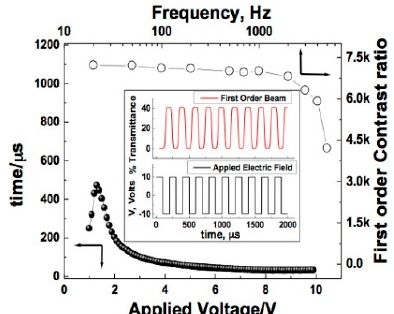
Figure 25. Voltage dependence of the response time at frequency of 500 Hz (solid circles) and frequency dependence of the first order contrast ratio at voltage of 10 V (open circles). Insertion shows the waveforms of the applied voltage (bottom) and the transmittance of first order (top) at frequency of 5kHz [47].